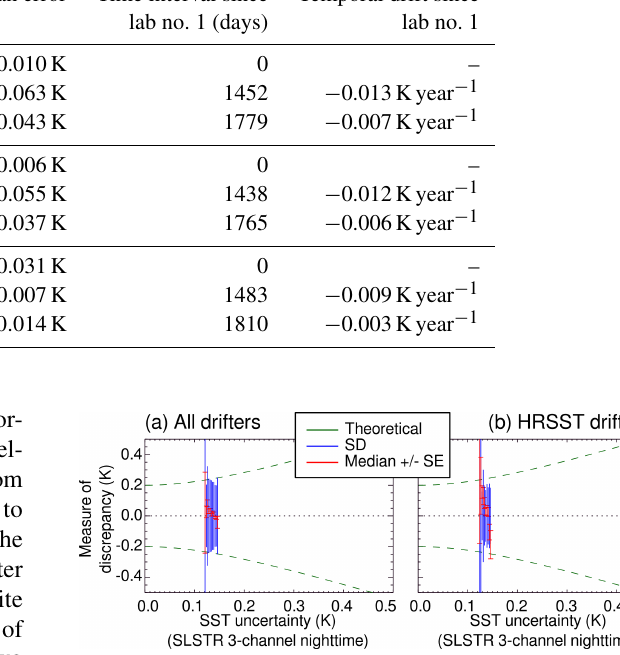
Table 3. Individual calibration data for SST sensors from three HRSST-2 buoys that were fortuitously recovered. The mean error is the average difference, for several verification points, between the temperature reported by the sensor and the temperature of the calibration bath. Lab. no. 1 indicates the initial calibration and verification that was made then. The last column, showing temporal drift (in Kyear − 1 ), is 365.25 times the difference between the mean error assessed by lab. no. 2 (or 3) minus the mean error assessed by lab. no. 1, divided by the number of days elapsed. WMO id. Lab. no.